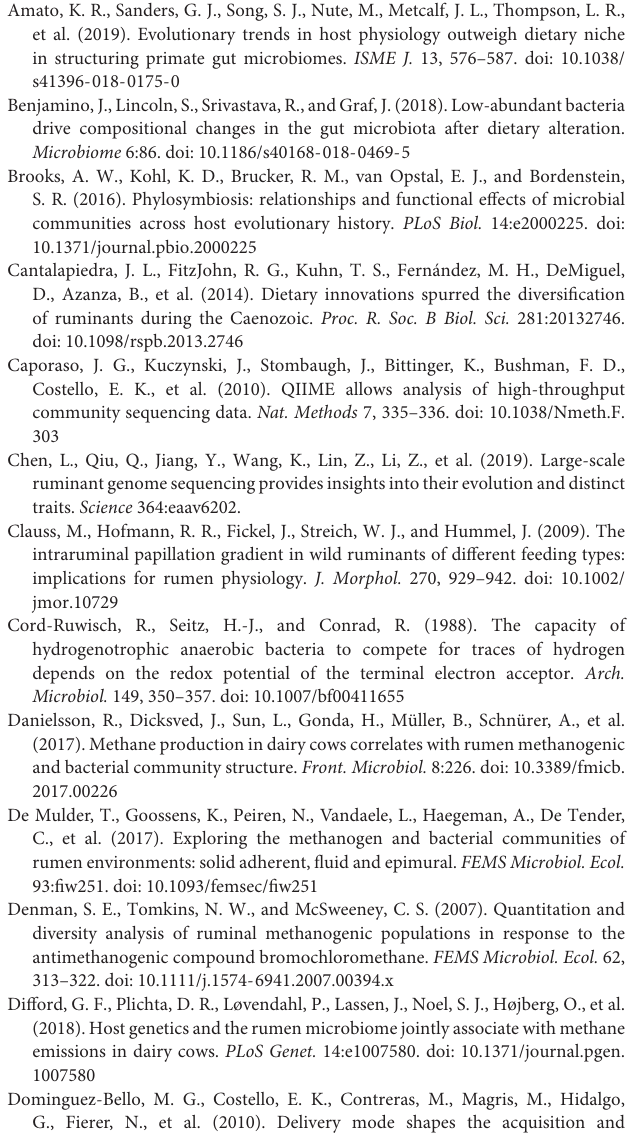
acetogens (D) . Abundance was expressed as log 10 copies of target gene per gram of wet weight. Target gene: 16S rRNA gene for bacteria; mcrA for methanogens; 18S rRNA for protozoa; fhs for acetogens. The different letters (a, b) denote significant differences (Kruskal–Wallis tests, FDR-adjusted p < 0.05). TABLE S1 | The distribution, habit, diet, and management of the ruminant species used in the present study. TABLE S3 | Comparison of the percentage of rumen volatile fatty acids (VFAs) among the 14 ruminant species. TABLE S4| The detailed comparison results of rumen VFAs among the 14 ruminant